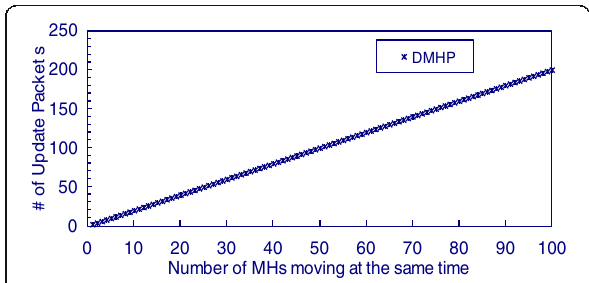
Fig. 18 Signaling overhead of DMHP for handover management of many MHs attach at the same time to the same N-PoA but each coming from different PoA